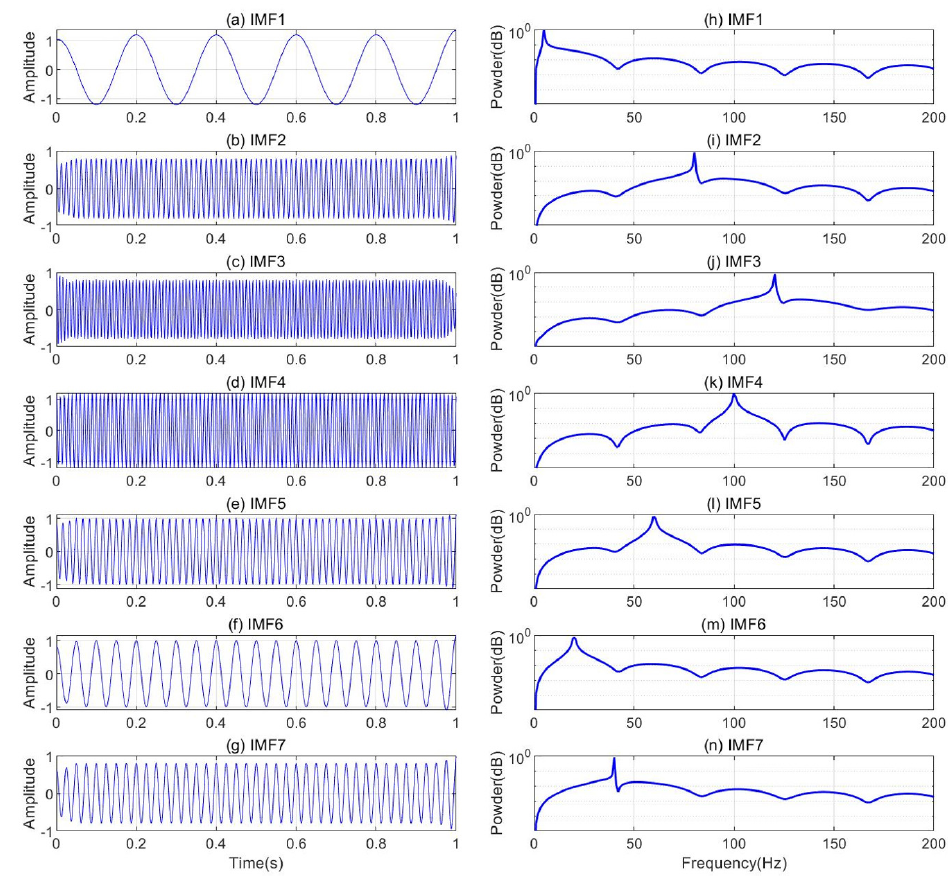
Figure 3. The decomposed IMFs ( a − g ) and their corresponding spectra ( h − n ) by PSO based param ‐ eter ‐ optimized VMD for the synthetic signal. optimized VMD for the synthetic